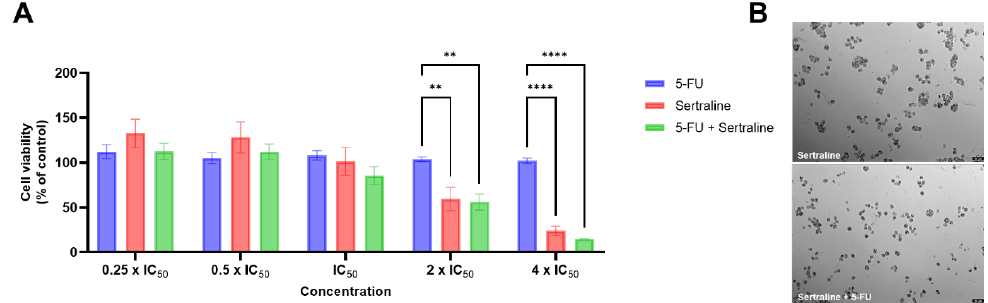
Figure 4. MTT results ( A ) and morphological analysis ( B ) of HT-29 cells treated for 48 h with a combination therapy of 5-FU and sertraline. Results are expressed in relation to control cells (treated with vehicle) and represent mean ± SEM. Each experiment was repeated three times ( n = 3); ** sta- tistically significant vs. control at p < 0.01. **** statistically significant vs. control at p < 0.0001. Scale bar: 50 µm. Reprinted with permission from Duarte et al. (2021). Copyright 2021 Copyright Duarte et al. [47].